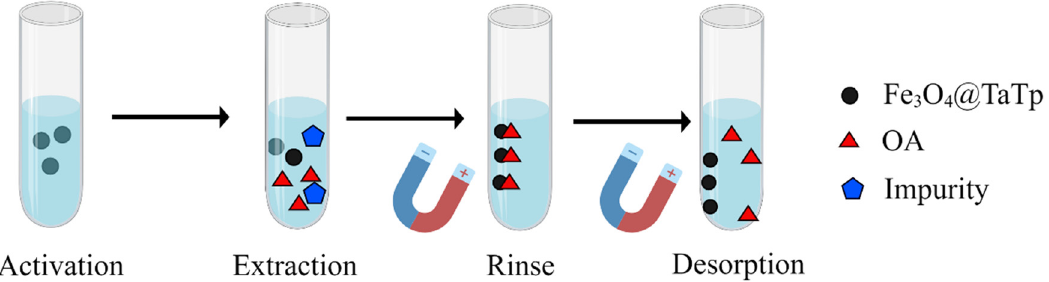
Figure 2: Procedure of magnetic solid - phase extraction for OA from seawater and shell fi